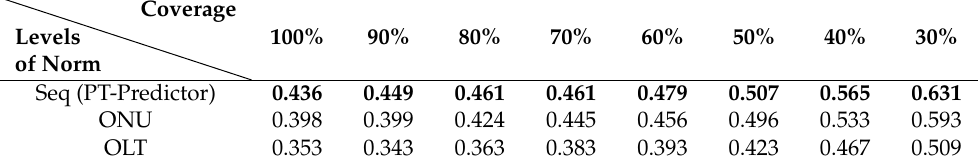
Figure 10. Accuracy through different methods. ( a ) Normalization levels. ( b ) Scoring methods. ( c ) Data-based voters. ( d ) Voting methods. Table 3. Accuracy through different levels of normalization.